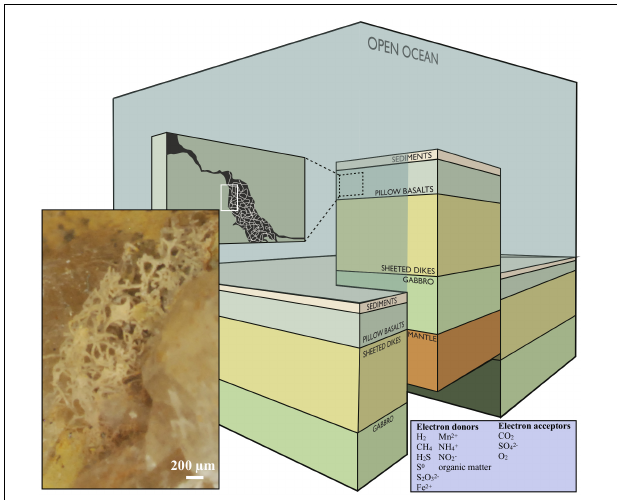
FIGURE 1 | Conceptual image modified after Ivarsson et al. (2016), showing a cross section of the oceanic crust. Fungal hyphae colonize veins and vesicles in pillow basalts and form extensive three-dimensional mycelia [this is visualized in the dark-green box marked (A) and the enclosed stereomicroscope image]. The image is under the CC BY-NC-ND license